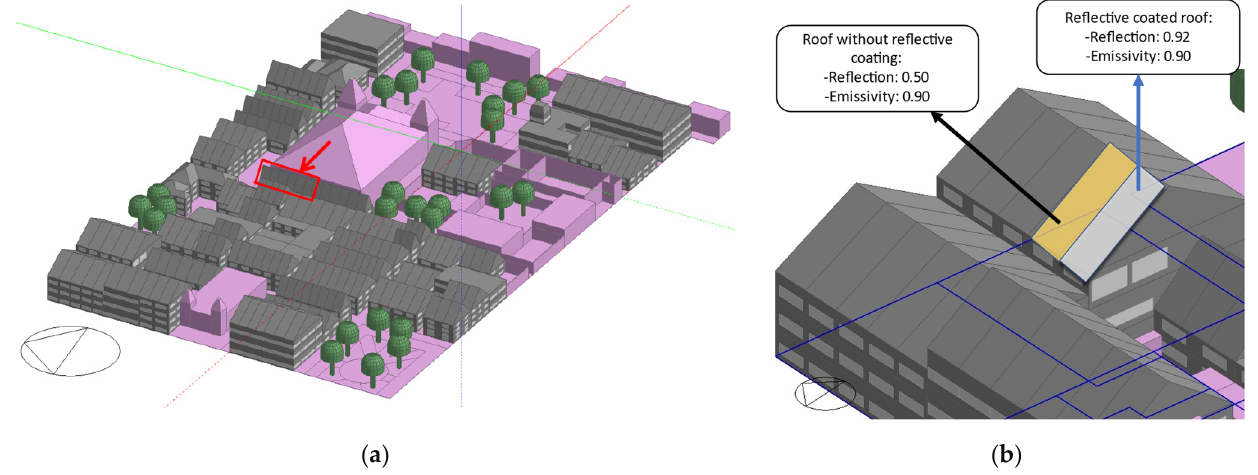
Figure 5. Proposed case: ( a ) 3D model in Designbuilder (selected building for further analysis inside red box) and ( b ) the order of applied reflectivity and its properties. Own elaboration. Table 4. Layers in the pitched roofs based on the base case. Own elaboration.